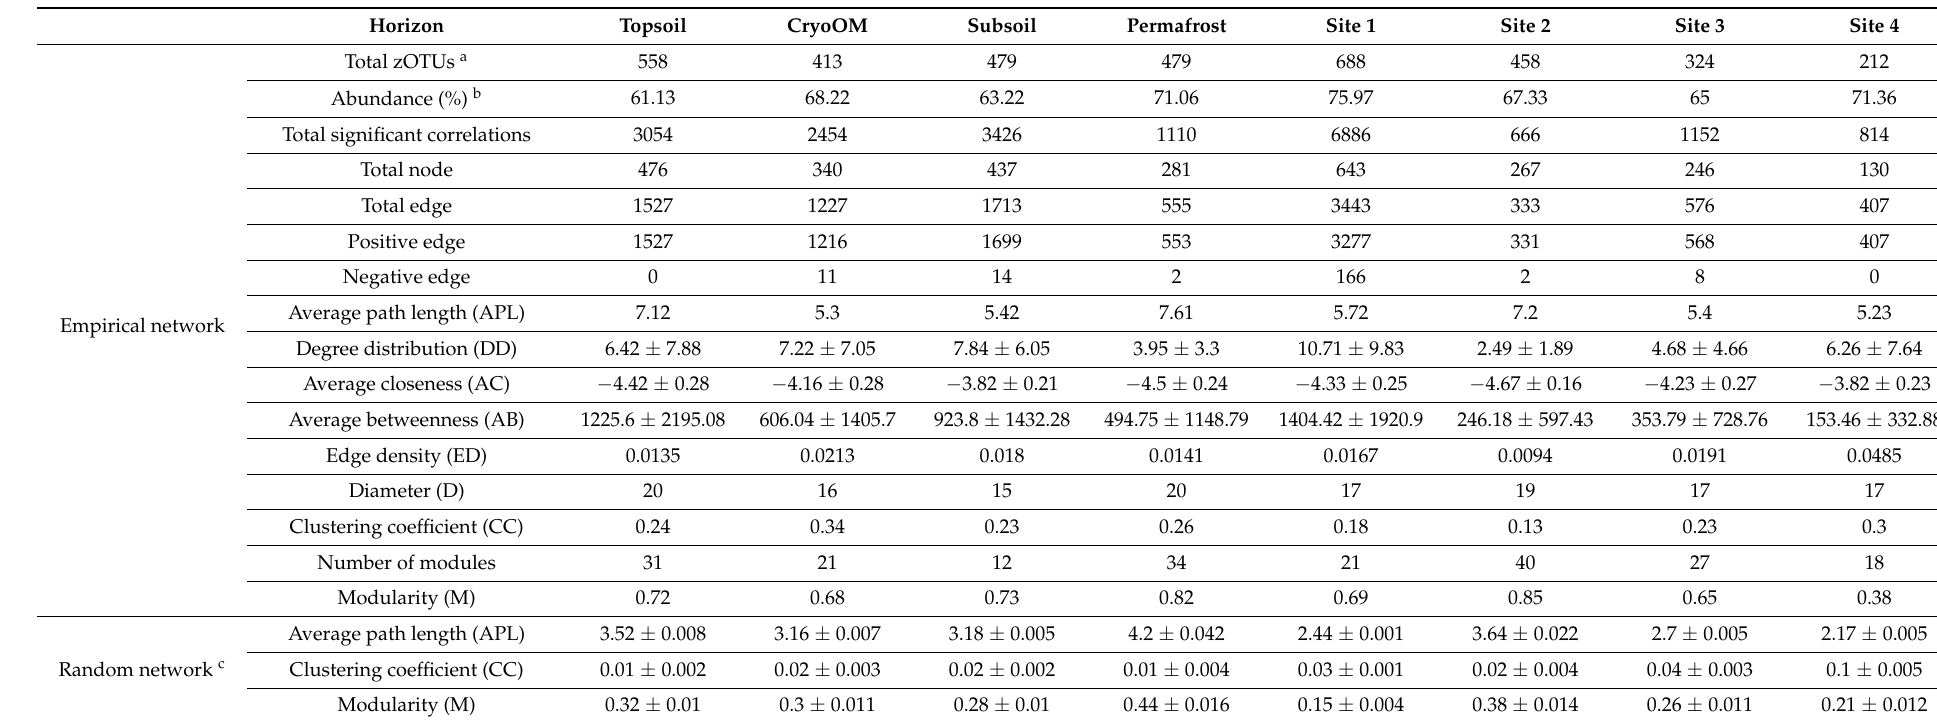
Table 2. Major topological properties of the empirical networks of soil fungal communities in different horizons and tundra sites, and their associated random network.